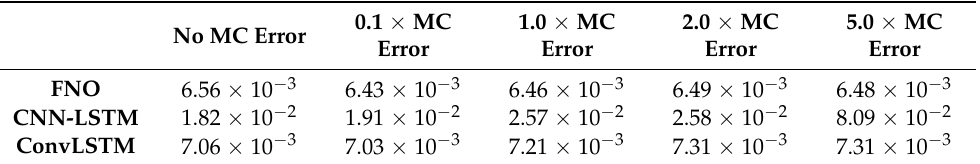
Table 2. Impact of mass conservation weights on validation RMSE obtained by all optimized model architectures after a maximum of 300 epochs.